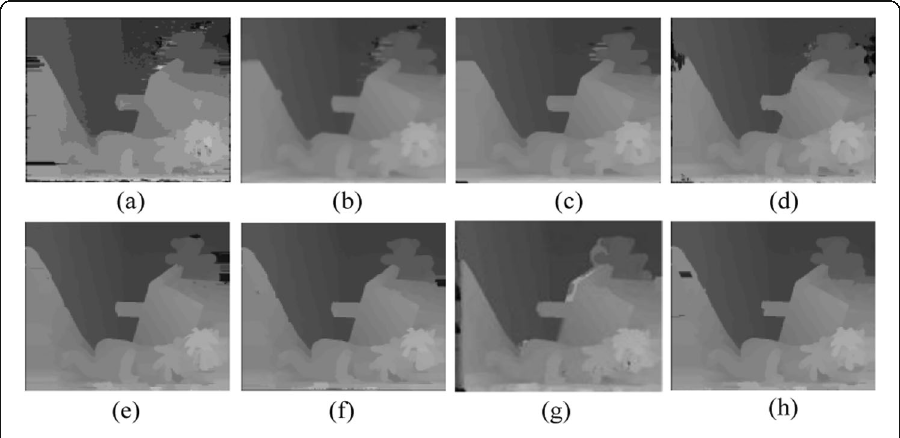
Fig. 16 Estimated disparity maps of Teddy achieved by a Kuo et al. [27], b Kuo [28], c Hsieh [29], d Sun [31], e ASW [21], f S-ASW [23], g LF-SM [36], and h the proposed